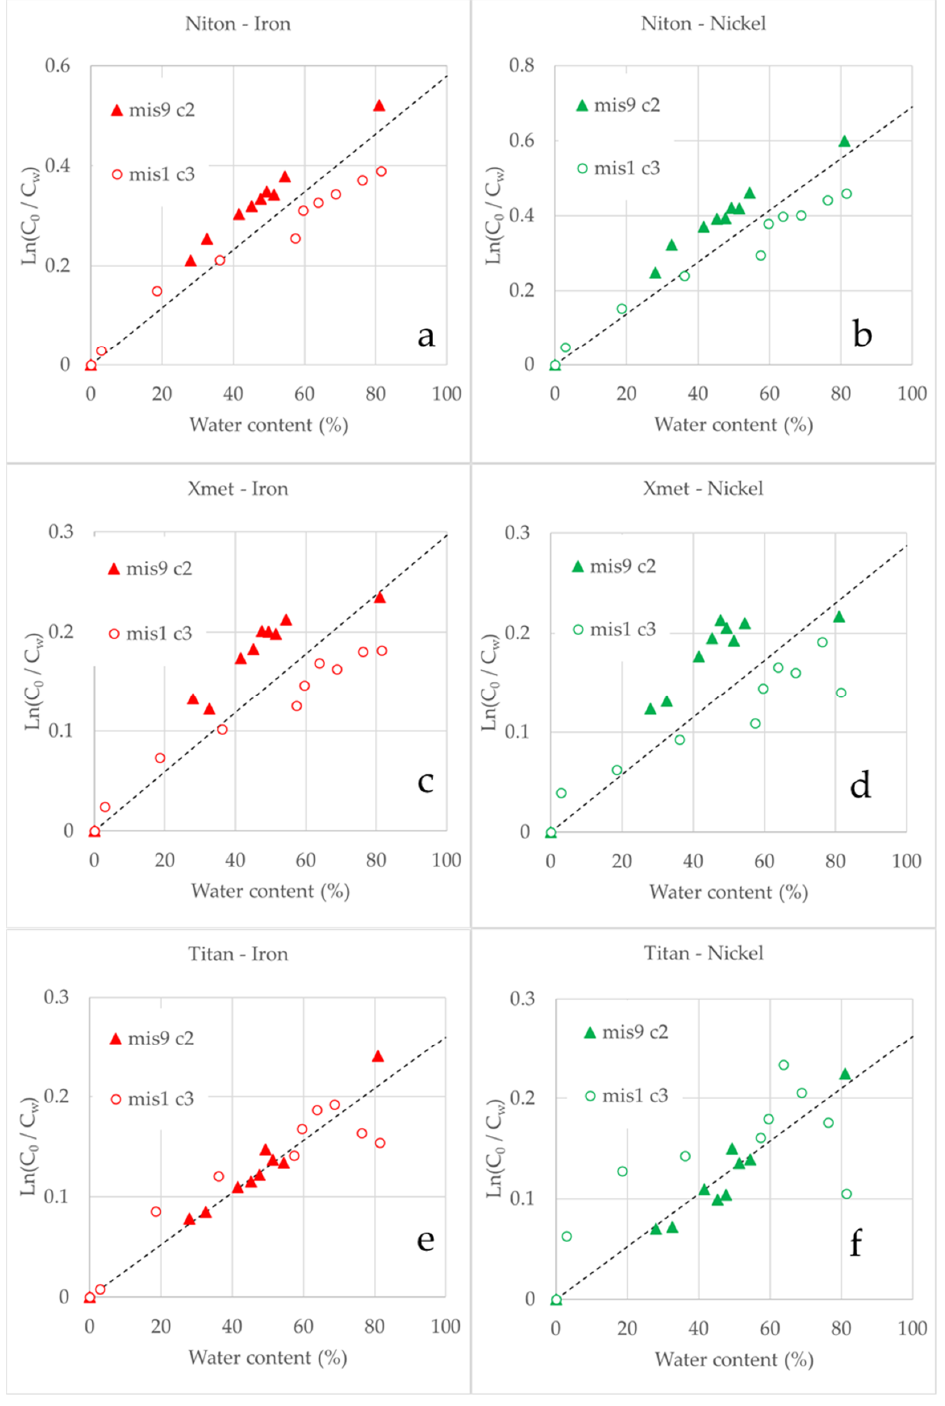
Figure 15. Ni and Fe concentrations in wet conditions divided by concentrations in dry conditions according to water content (expressed in wt%) for 2 samples. The dashed line corresponds to the fitted regression where attenuation coefficients are given in Table 5: ( a , b ) Niton, ( c , d ) Xmet and ( e , f ) Titan.